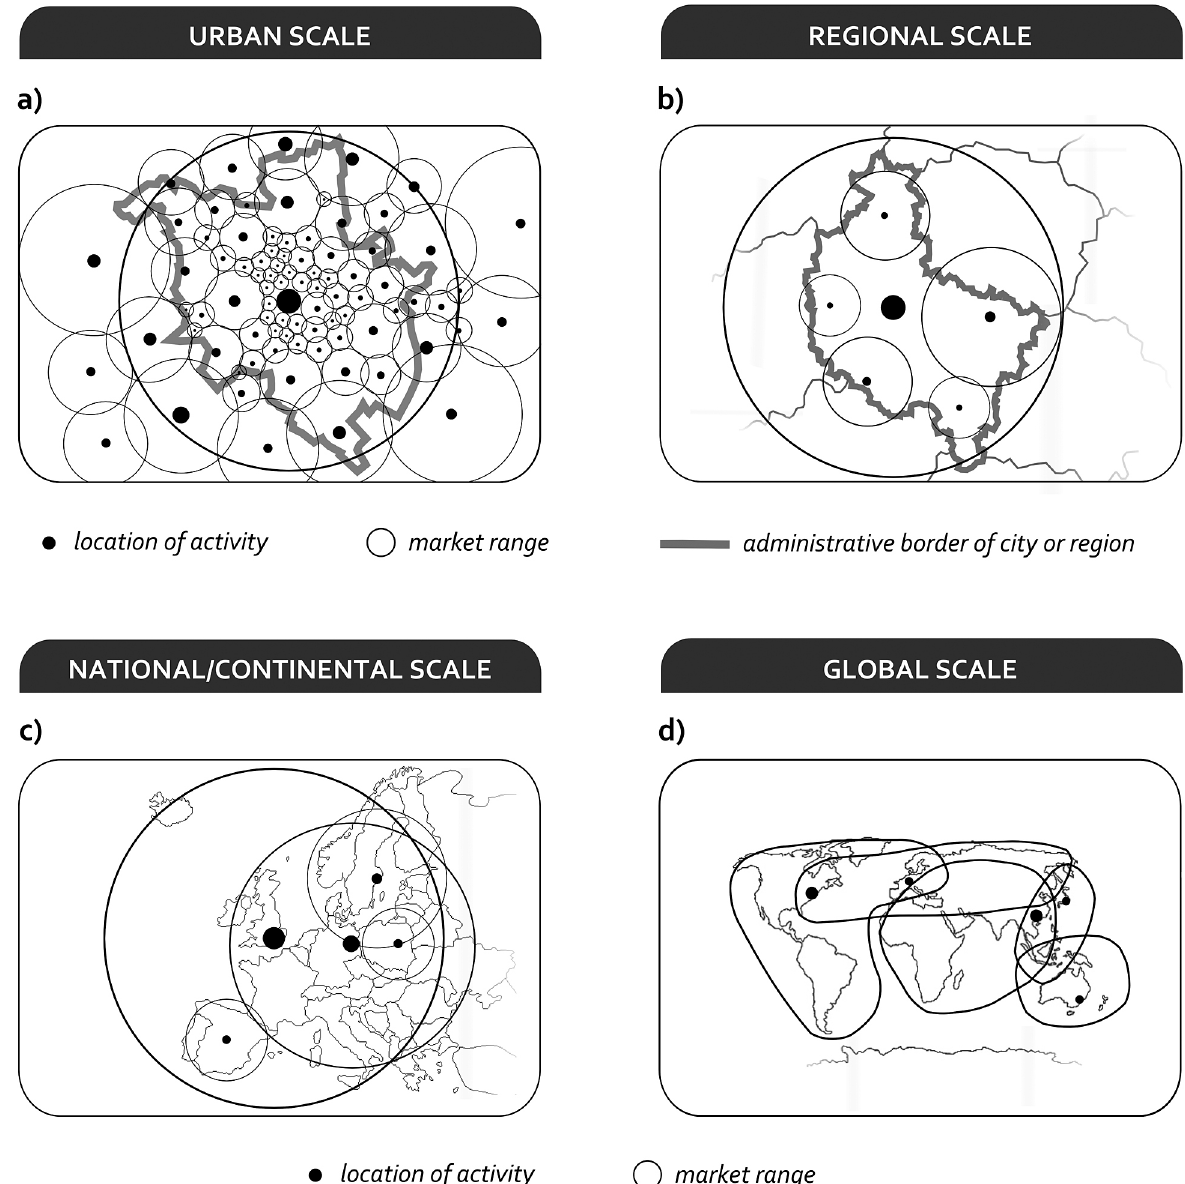
Fig. 5. Diagrammatic presentation of CCI market ranges. Source: own